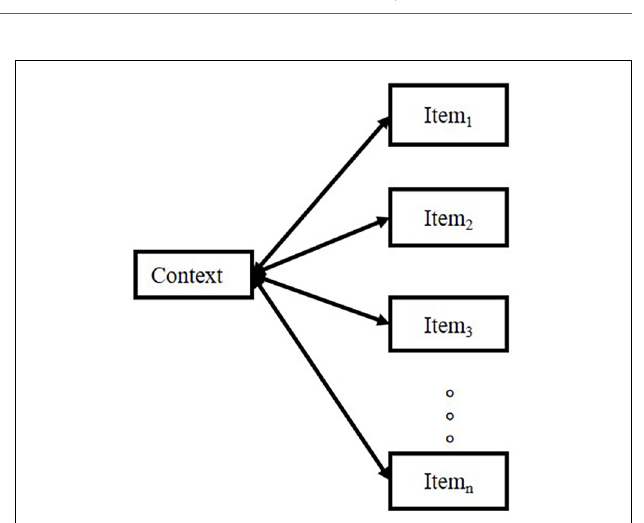
FIGURE 2 | The logic of the model studied by Raaijmakers and Schiffrin